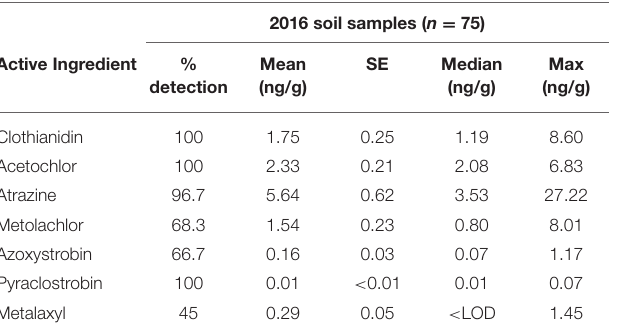
TABLE 4 | Summary data for pesticides detected in soil samples collected from the field in 2016. 2016 soil samples ( n =